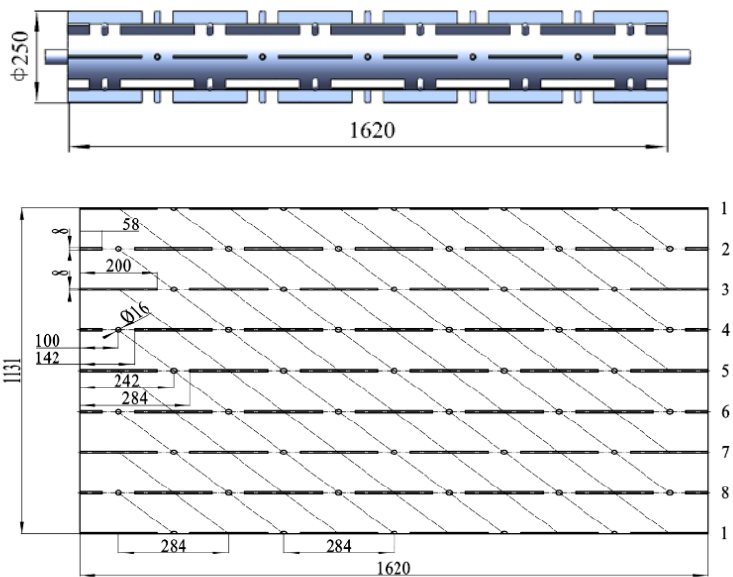
Figure 8. The tuber picking drum. Legend: The inclined dotted line represents the spiral line on the